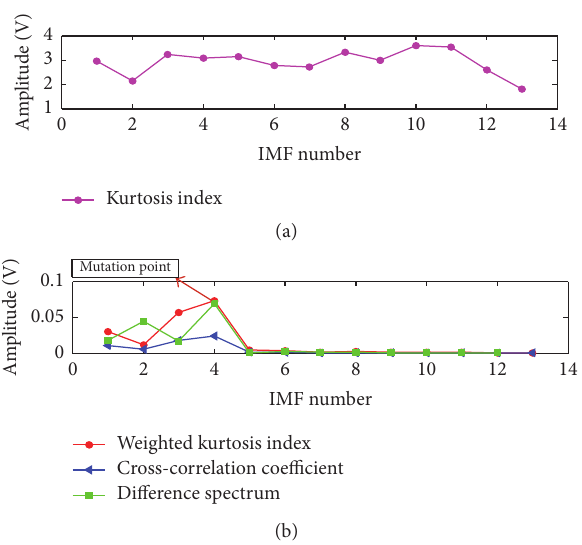
Figure 6: WKIDS of the inner race of the bearing: (a) kurtosis index; (b) weighted kurtosis index, cross-correlation coefficient, and difference spectrum.